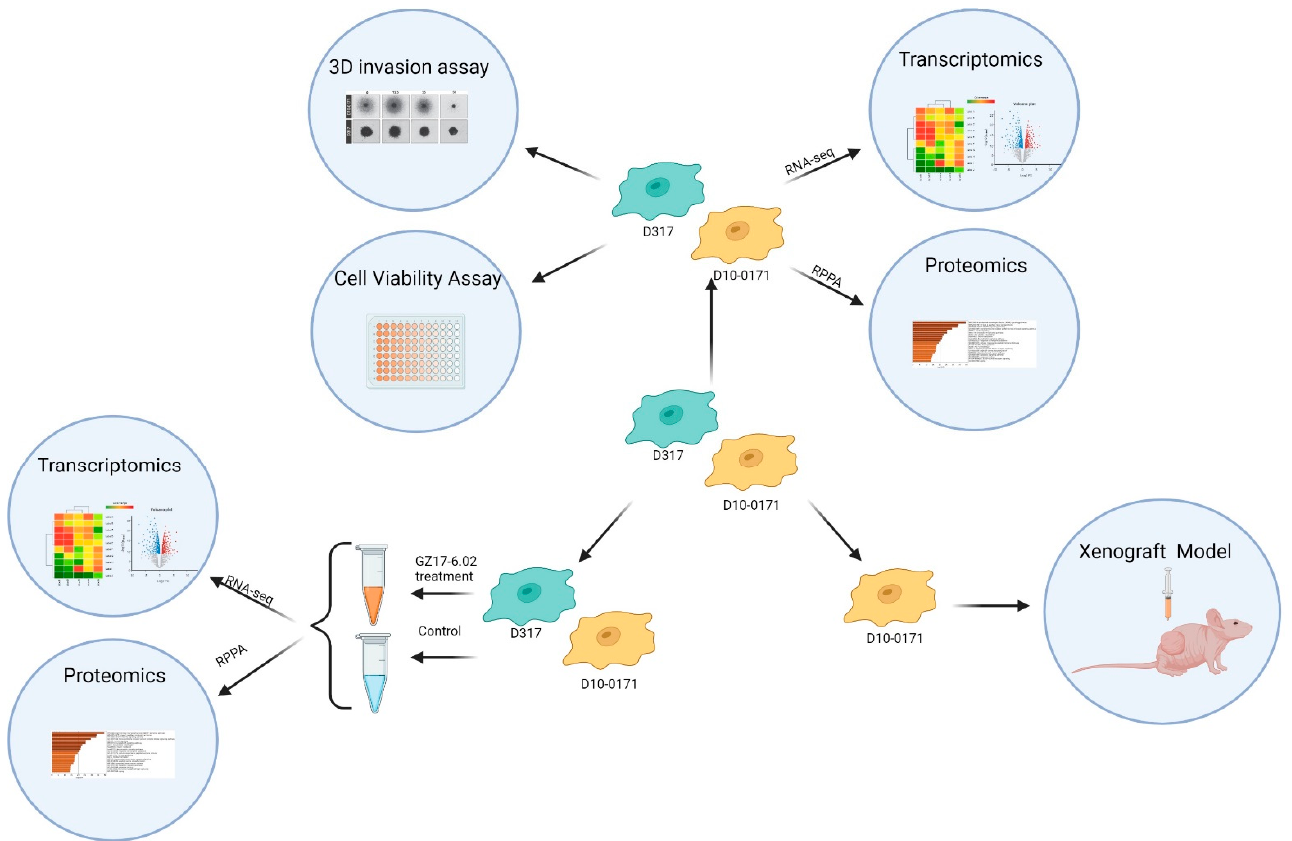
Figure 1. Overall study design. GSC lines D10-0171 and D317 were utilized to test the ability of GZ17-6.02 to inhibit the growth of EGFRvIII+ glioblastoma. The molecular differences between these cell lines were determined with Matrigel invasion and cell viability assays, transcriptomic analysis, and proteomic analysis. These cell lines were also used to characterize the gene and protein expression changes that occur as a result of GZ17-6.02 treatment. The more invasive D10-0171 alone was utilized in a subcutaneous xenograft model. RPPA, reverse phase protein analysis. This figure was created with biorender.com (accessed on 2 February 2022).